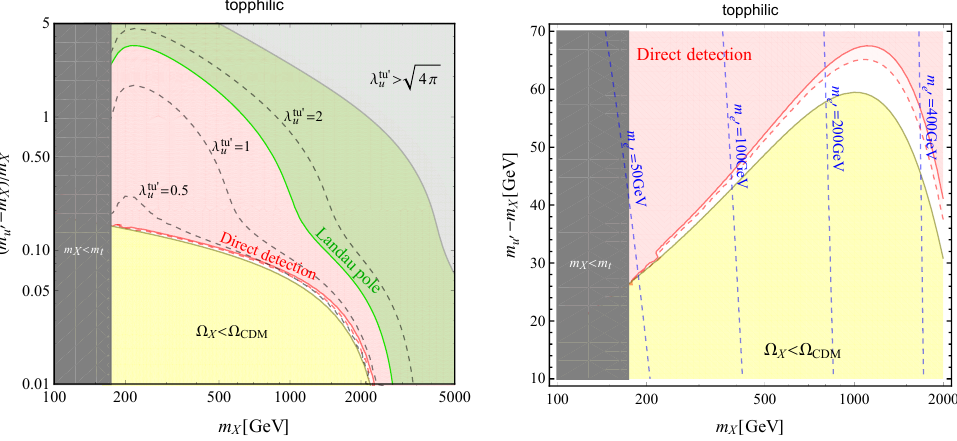
Figure 3 . Similar to the charm-philic case, m top-philic case. White region is relatively larger than that in charm-philic